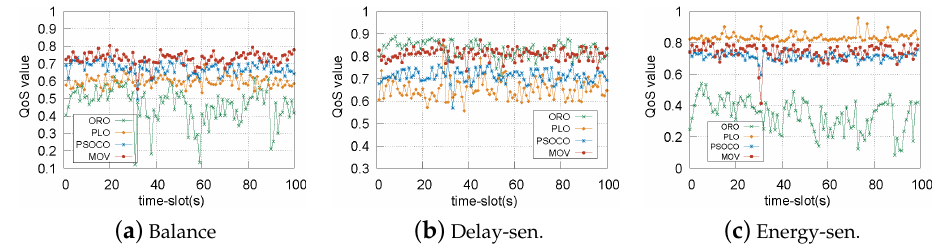
Figure 7. QoS values of ORO, PLO, PSOCO, and MOV with different